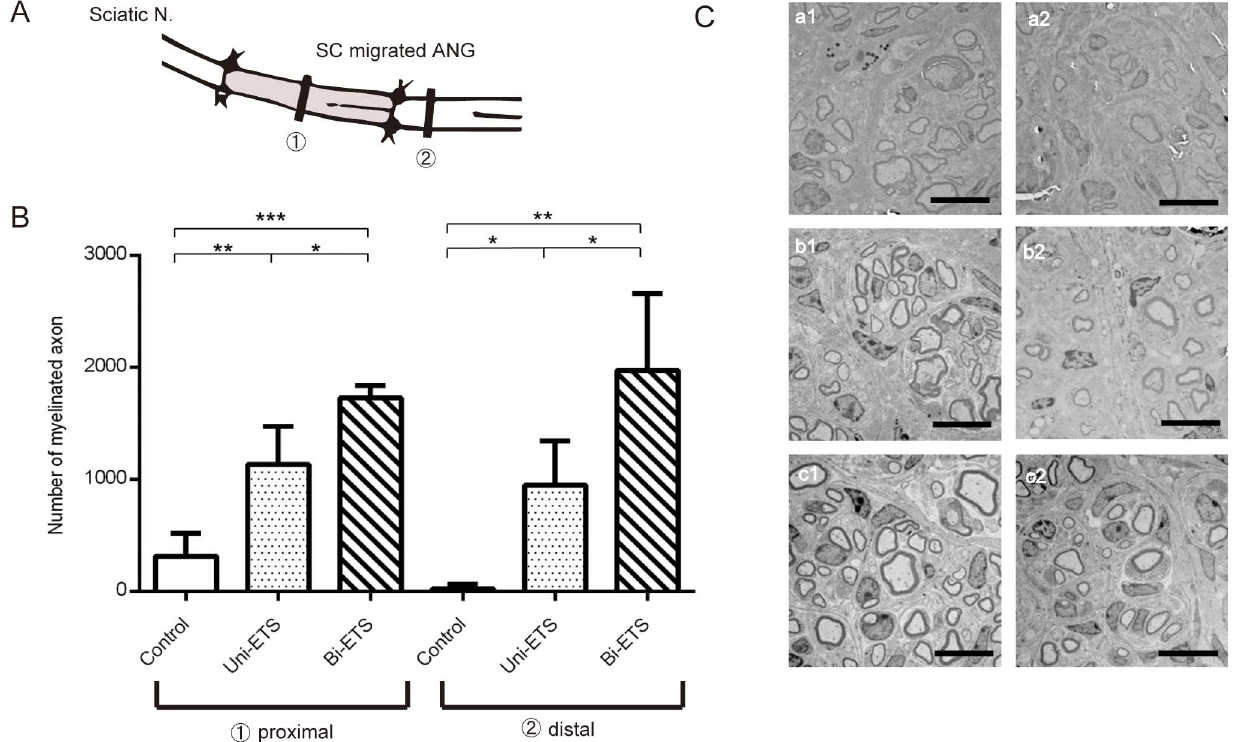
Fig 7. Histomorphometry in the engraftment model. A) Axonal regeneration was evaluatedat the 1) proximal:midgraft and 2) distal section, 2 mm distal to the graft (4 weeks post transplantation; n = 4 per group). B) Number of myelinatedaxon into the graft. Left: proximal,right: distal. Myelinatedfibers in the bilateral end-to-side (ETS) group were the highest, followedby the unilateralETS and control groups. Differences amongall groupswere significant. * p < 0.05, ** p < 0.01, *** p < 0.001. C) Electron micrograph of the proximaland distal section. a1–a2)In the control group, proximaland distal sections, respectively, from regenerating nerves of the control group. A small minority of regenerated fibers were confirmedcomparedwith the other groups. Moreover, histological feature was a predominance of thin myelinatedfibers in the three groups. b1–b2)In the unilateralend-to-side(ETS) group, proximaland distal sections, respectively, from regenerating nerves of the unilateral ETS group. The numberof regenerated fibers was increasedmore than the control group. The number of regenerated fibers both proximaland distal section exponentially increasedcomparedwith the control group. In addition, there were a numberof thick myelinatedfibers at the distal section comparedwith the control group. c1–c2) In the bilateralETS group, proximaland distal sections, respectively,from regenerating nerves of the bilateralETS group. The number of regenerated fibers at the distal section dramatically increasedcomparedwith the unilateralETS group. Furthermore, at the distal section, abundantmyelinatedfibers appearedto have a larger myelin thickness than the other groups. Scale bar, 10 μ